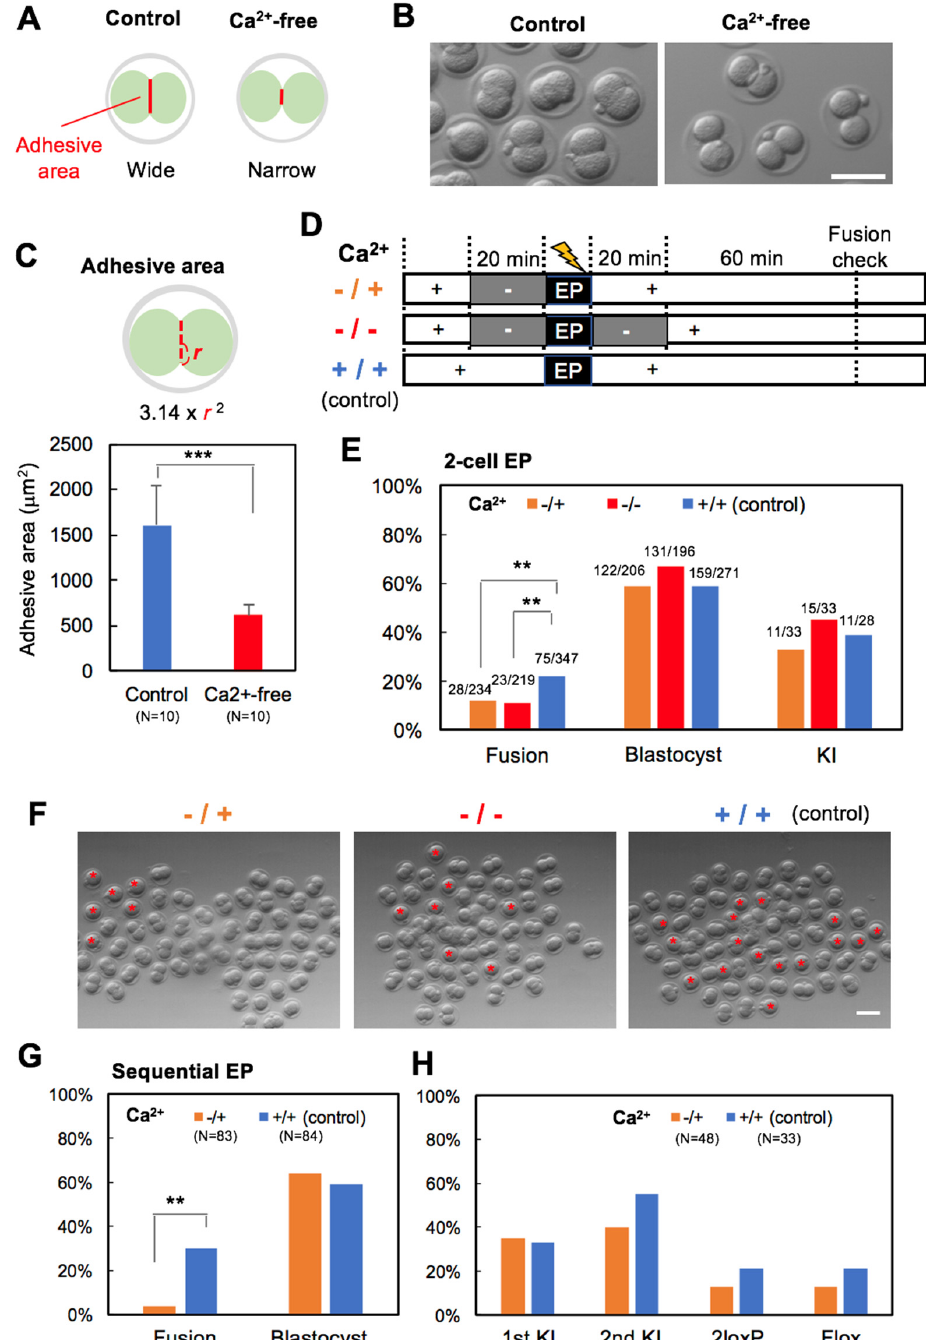
Figure 3. Effects of Ca 2+ -free buffer treatment on blastomere fusion and embryonic development of 2-cell EP. ( A ) Relationship between adhesive area and Cadherin inhibition by Ca 2+ -free treatment. ( B ) Morphology of 2-cell stage embryos (B6D2F1) after 20 min treatment of Ca 2+ -free buffer (PBS). ( C ) Adhesive area beween blastomeres. ( D ) Experimental timeline of Ca 2+ -free treatment. ( E ) Fusion, development (blastocyst) and KI rate by 2-cell EP after Ca 2+ -free M2 treatment. ( F ) Morphology of 2-cell EP embryos. Asterisks indicate fused embryos. ( G ) Fusion and development (blastocyst) rate of 2-cell stage embryos after sequential EP. ( H ) KI efficiency of blastocysts by sequential EP. 2loxP = embryos with two loxP sites in cis or trans ; flox = emryos with two loxP sites in cis . N indicates the number of 2-cell stage embryos ( G ) and blastocysts ( H ) used for the analysis. ** p < 0.01, *** p < 0.001 (compared with the control). Scale bars, 100 μ m.